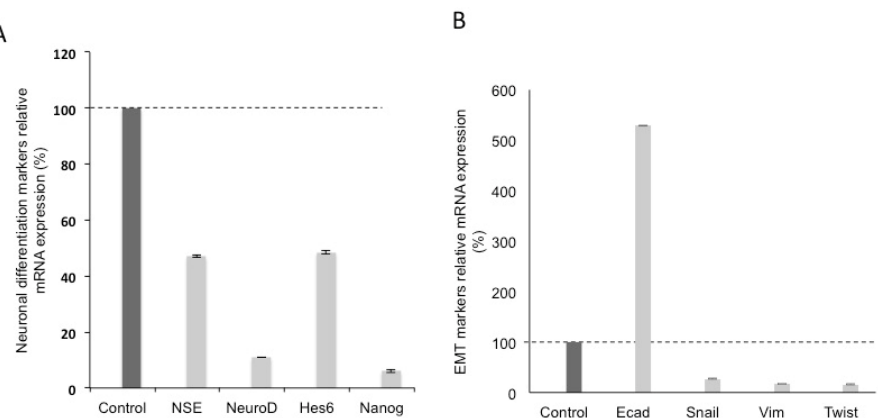
Figure 2. Wnt-11 promotes epithelial-mesenchymal transition (EMT) and neuronal di ff erentiation in Panc-1 cells line. ( A ) qRT-PCR for NSE, NeuroD, Hes6 and Nanog relative mRNA expressions after transfection of Panc-1 cells either with scrambled or Wnt-11 siRNA after 48 hours. ( B ) qRT-PCR for EMT markers; Ecad, Snail, Vim and Twist relative mRNA expressions after transfection of Panc-1 cells either with scrambled or Wnt-11 siRNA after 48 hours. NSE, NeuroD, Hes6 and Nanog mRNA expressions and they were reduced after silencing Wnt-11 (53%, 89%, 51.5% and 94% respectively; n = 6; p < 0.05 for all). Wnt-11 siRNA increased Ecad mRNA expression 5.29-fold in Panc-1 cells ( n = 6; p = 0.02). Other EMT markers, such as Snail, Vim and Twist expressed in Panc-1 and